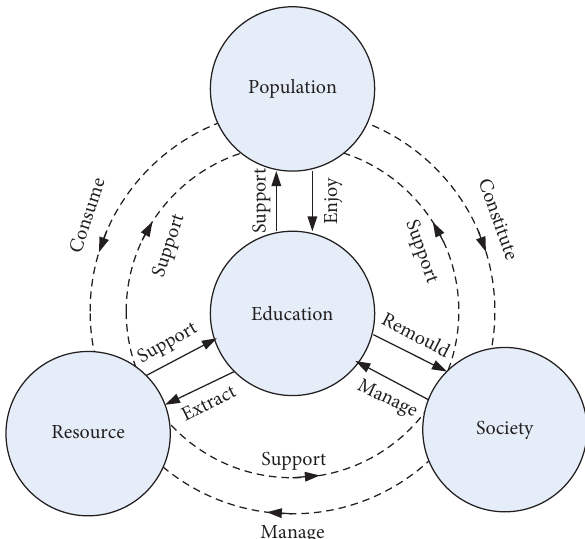
Figure 1: Educational PRES analysis framework